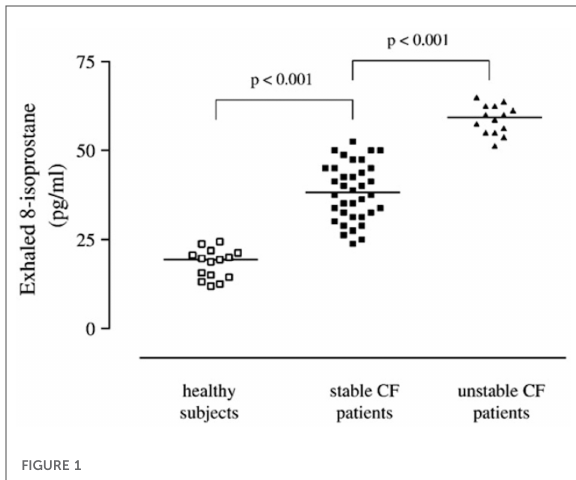
FIGURE 1 Adapted from “ Exhaled 8-isoprostane and prostaglandin E(2) in patients with stable and unstable cystic fi brosis ” : 8-Isoprostane concentrations in exhaled breath condensate in healthy subjects (open squares) and patients with stable ( fi lled squares) and unstable ( fi lled triangles)cystic fi brosis. Horizontal bars represent median values